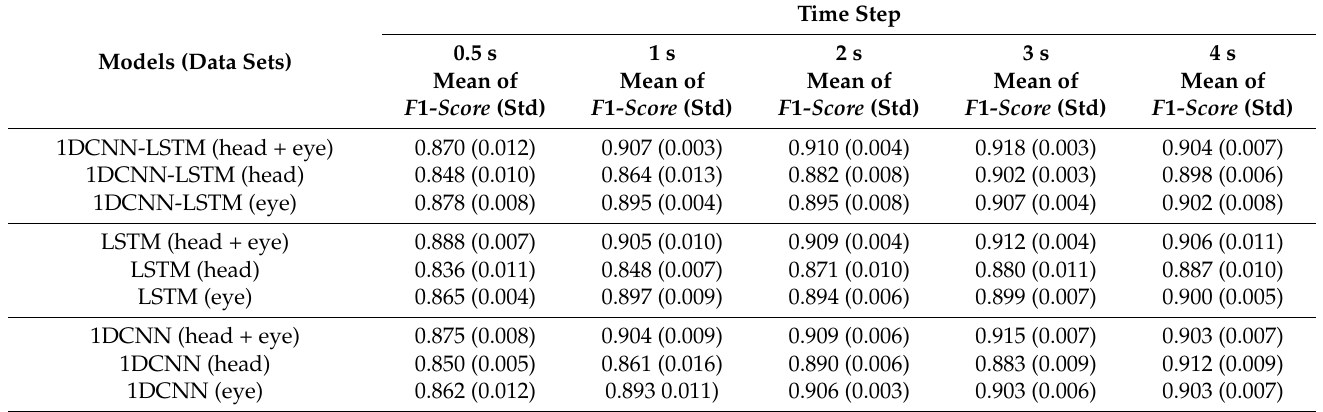
Table 2. Comparison of the F 1- score of each model.